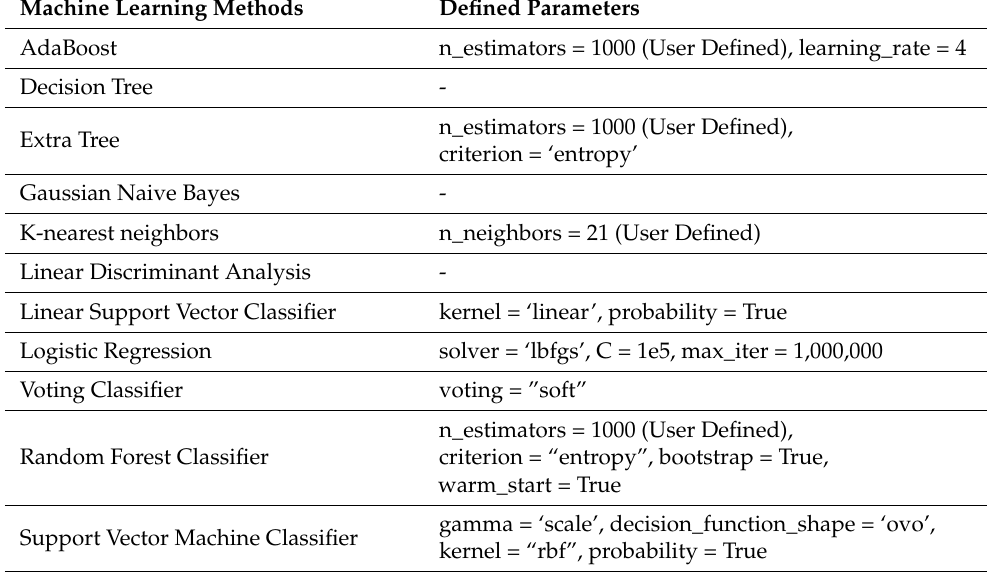
Table 1. Machine Learning parameters used for training. The method name and the code parameters are listed based on the Python3 SciPy package. If left blank, it means default parameters were used. Machine Learning